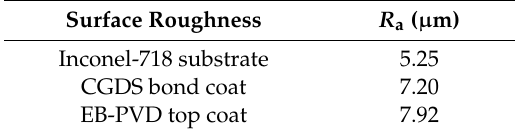
Table 1. Surface roughness values of substrate, and bond and top